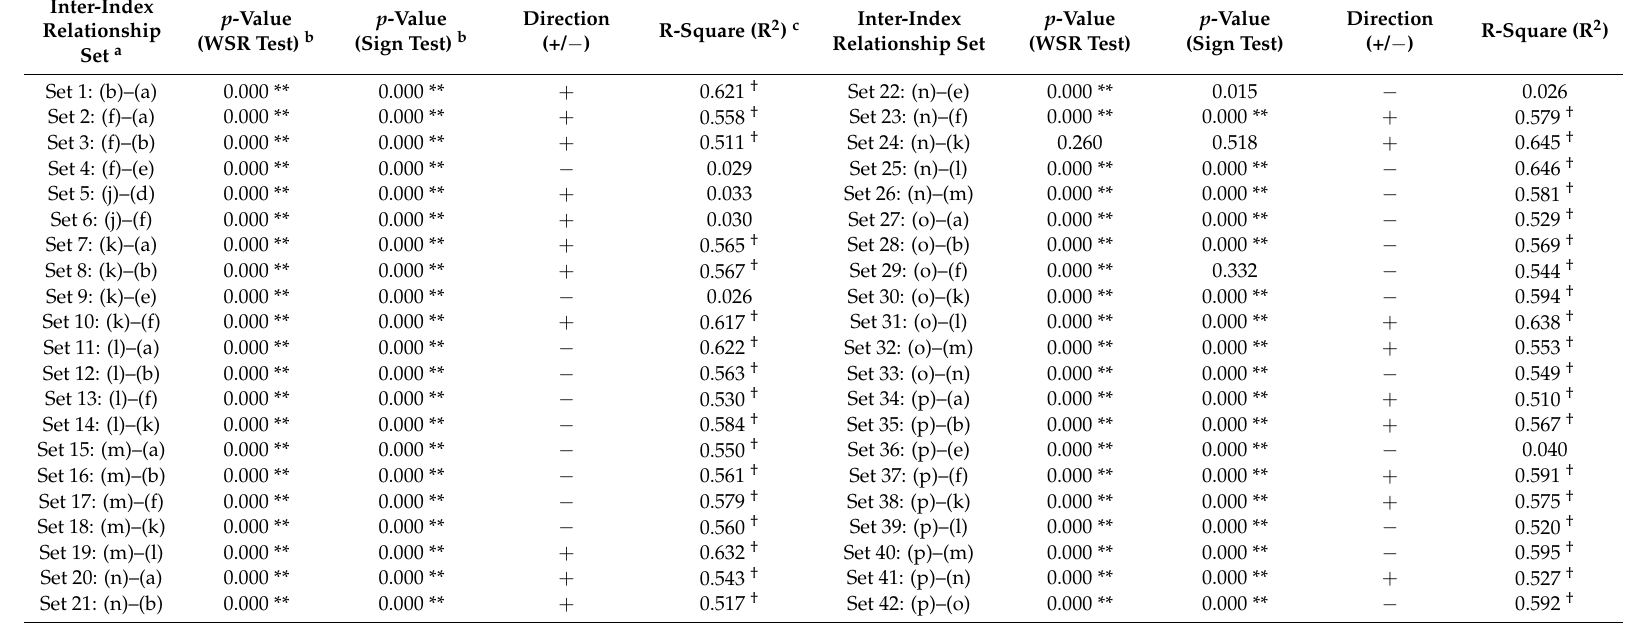
Table 5. Statistical pairwise comparisons between socio-centric